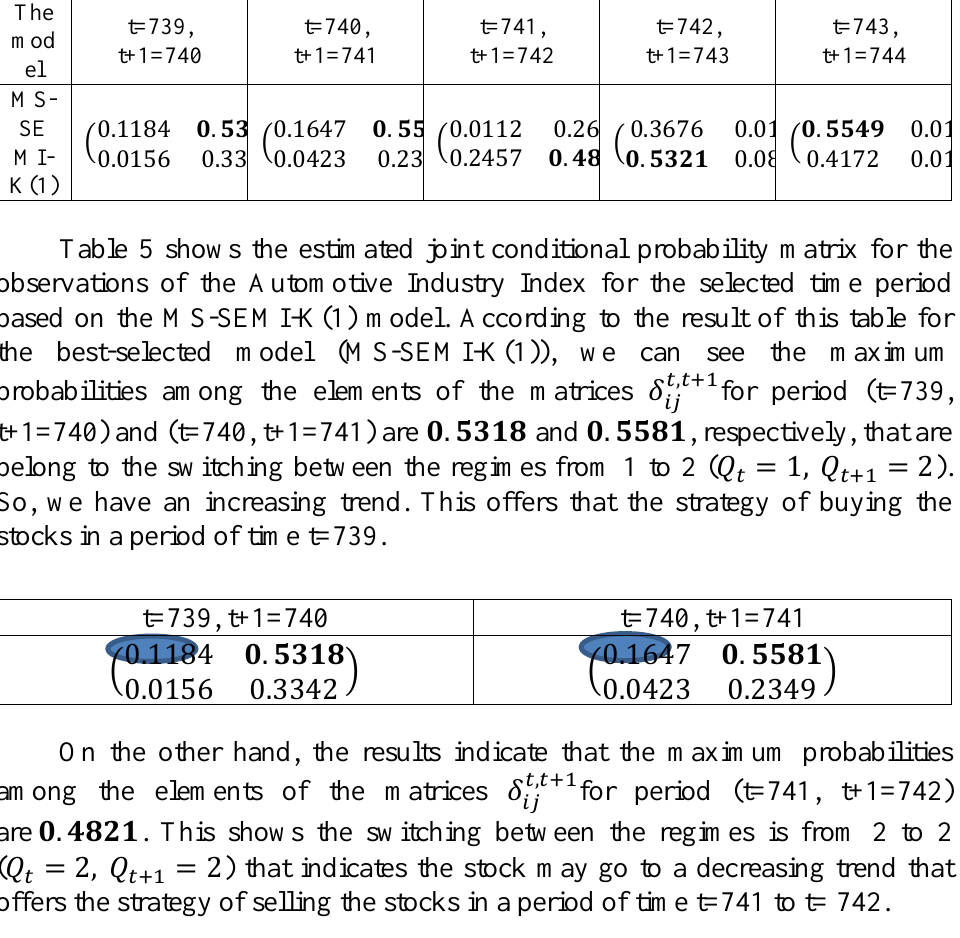
Table 5. The estimated joint conditional probability matrix based on the six models Time